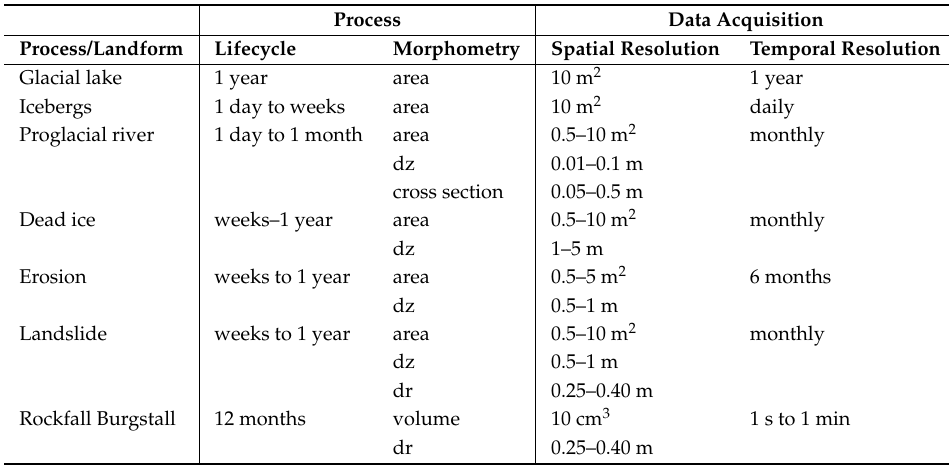
Table 6. Schematic classification of processes and data acquisition: quantification of lifecycle (persistence), morphometry, spatial resolution, and temporal resolution. Codes: area, area of landform; dz , vertical difference; dr, differential range → euclidean distance.